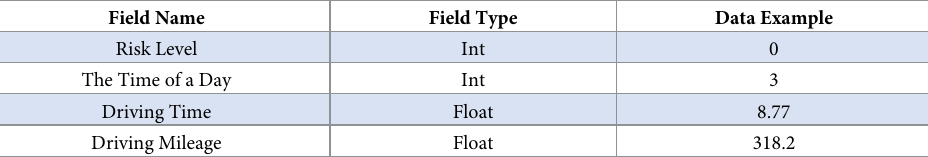
Table 3. The input data structure of DBRPNN.